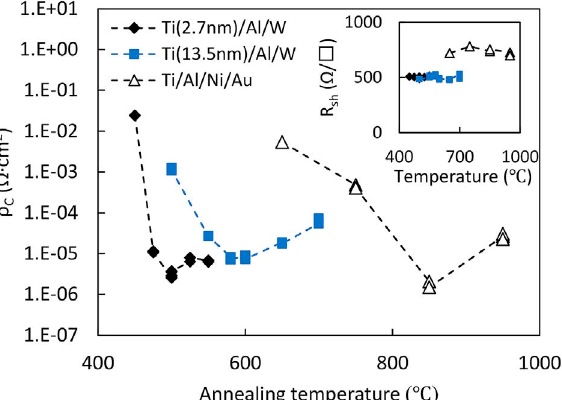
Figure 8. Specific contact resistivity ρ C vs. annealing temperature. All samples were annealed for 1 min, expect for samples with Ti (2.7 nm)/Al/W, which were annealed for 10 min. The inset shows the corresponding channel sheet resistances Rsh. Reprinted with permission from Ref. [33]. Copy- right 2018, Wiley.